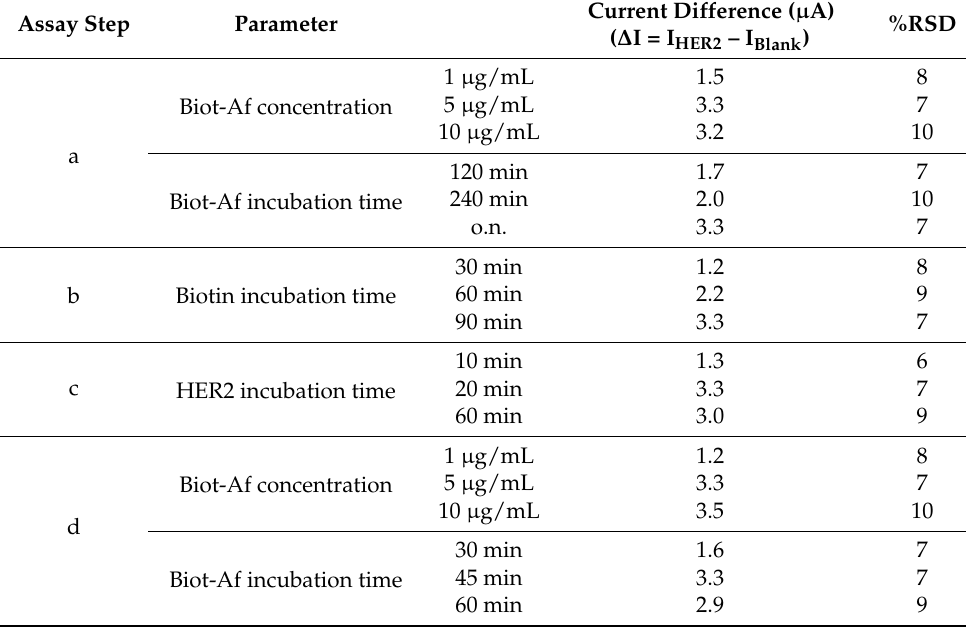
Table 1. Experimental parameters optimization for affibody-based sandwich assay. Current difference ( ∆ I = I HER2 – I Blank ) represents the difference between the current obtained using 10 ng/mL (I HER2 ) and 0 ng/mL (I Blank ) HER2 buffered solutions. The letters of assay step column are in accordance with Scheme 1. Percentage Relative Standard Deviation (%RSD) values were calculated using at least 10 measurements obtained by different screen-printed